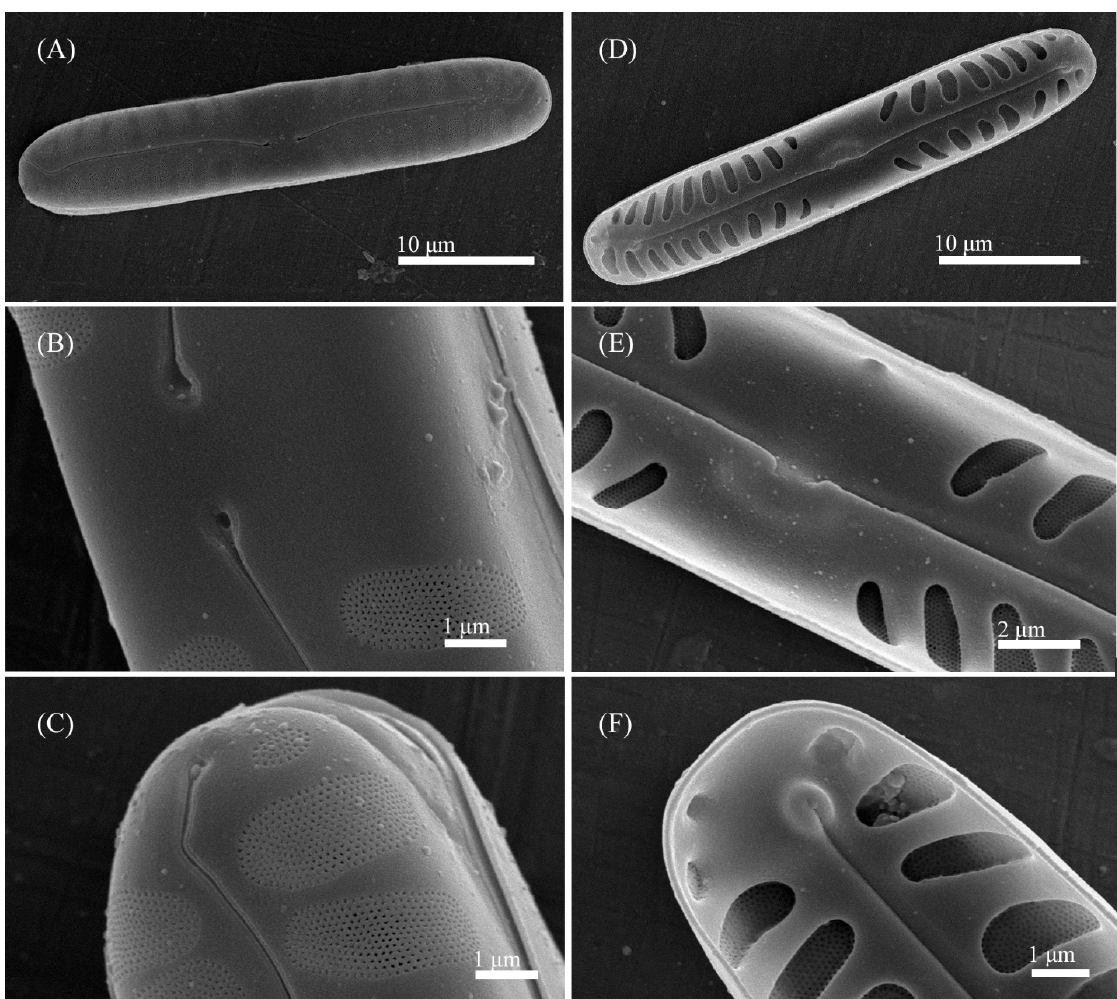
Figure 14. Pinnularia paradubitabilis Kezlya, Maltsev, Krivova et Kulikovskiy sp. nov. Strain VP563 sample No. 07116. Scanning electron microscopy. ( A – C ) External views. ( D – F ) Internal views. ( A , D ) The whole valve. ( B , E ) Central area. ( C , F ) Valves ends.